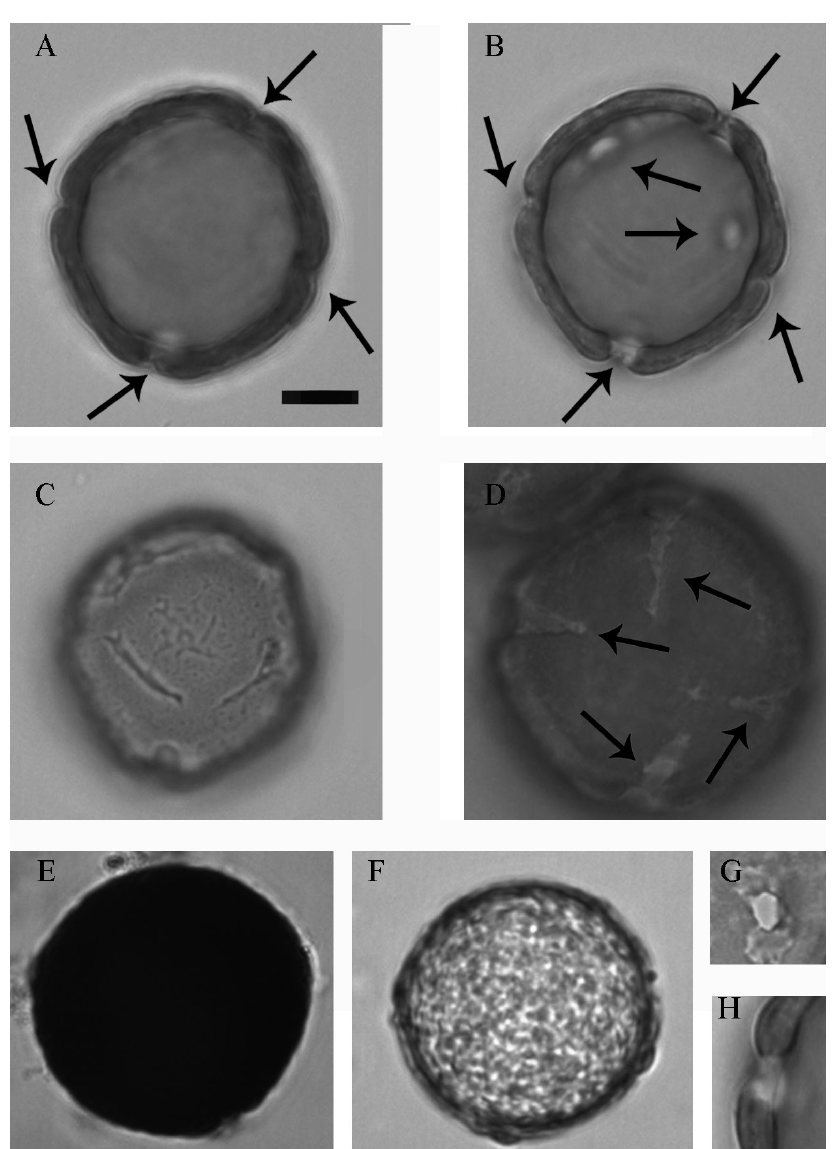
Fig. 4 – Acetolyzed pollen grains of H. umbellata , (A) Vision of 4 apertures (arrows), (B) Vision of 6 apertures (arrows), (C) Vision of exine, (D) Vision of colpoids (arrows), (E) Starch positive grain stained with Lugol, (F) Lipid negative grain stained with Sudan IV, (G-H) Details of pores. Barr = 5 μ